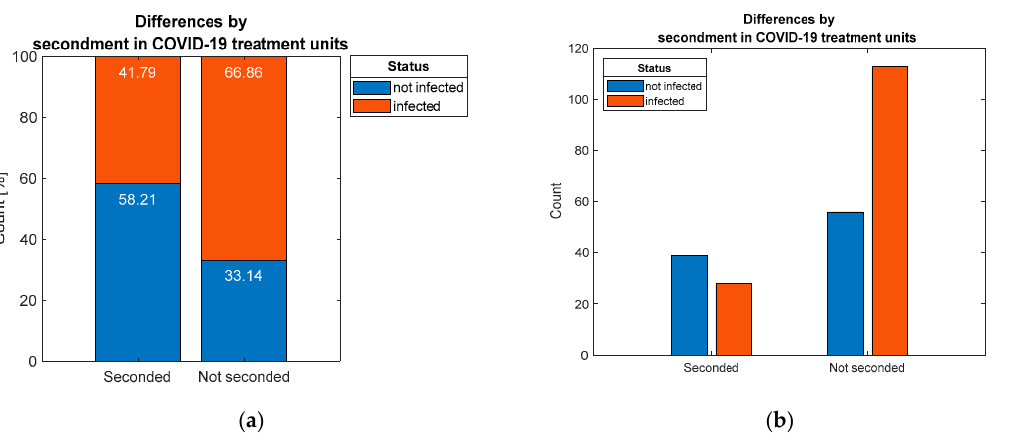
Figure 8. Distribution of respondents by: ( a ) percentage and ( b ) count, considering differentiation by secondment in COVID-19 units.